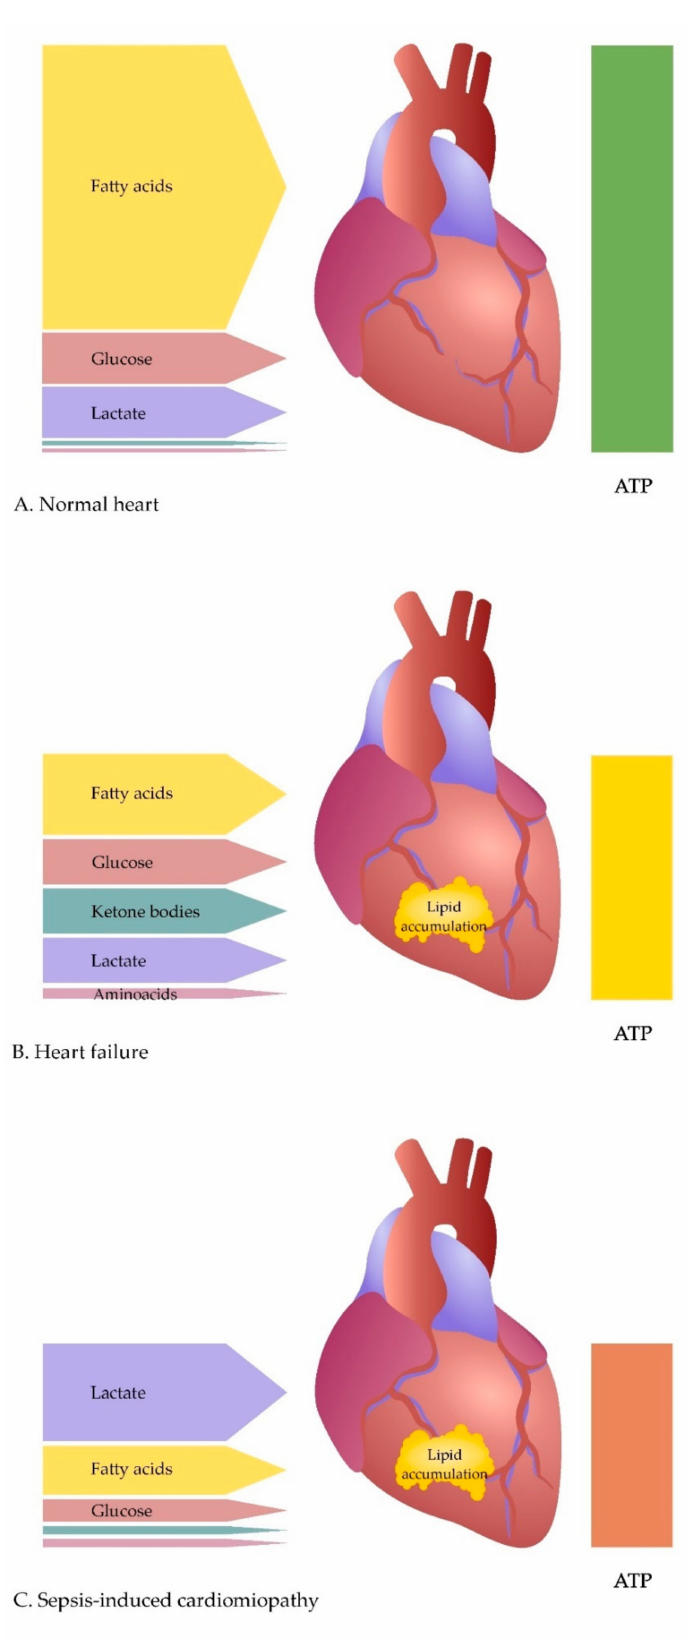
Figure 1. Comparison of energy metabolism in a healthy heart ( A ), in the course of heart failure ( B ), and sepsis-induced cardiomyopathy ( C ). Abbreviations: ATP = adenosine